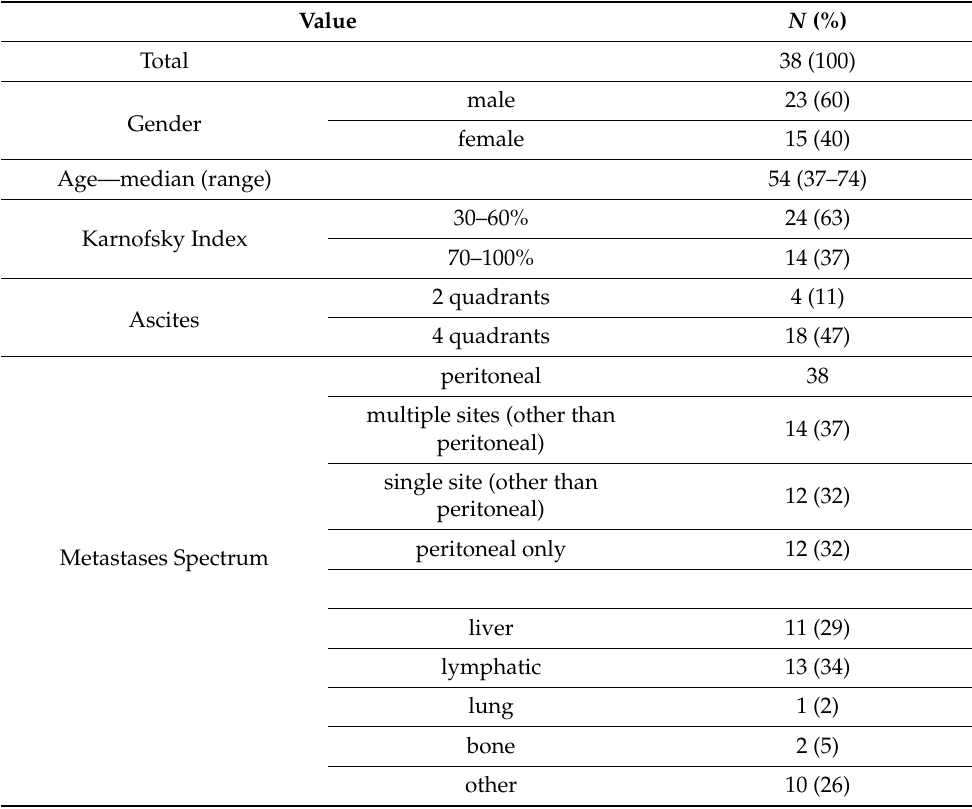
Table 1. Patient